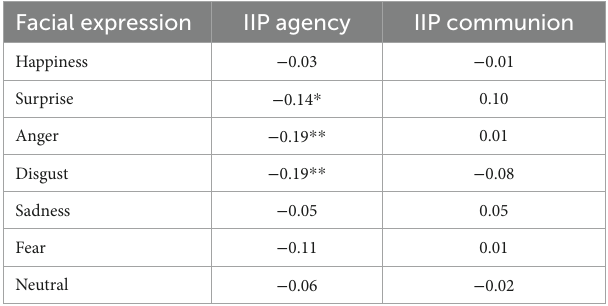
TABLE 3 Correlations between interpersonal dimensions (IIP) and recognition of emotional facial expressions (unbiased hit rates). Facial expression IIP agency IIP communion Happiness −